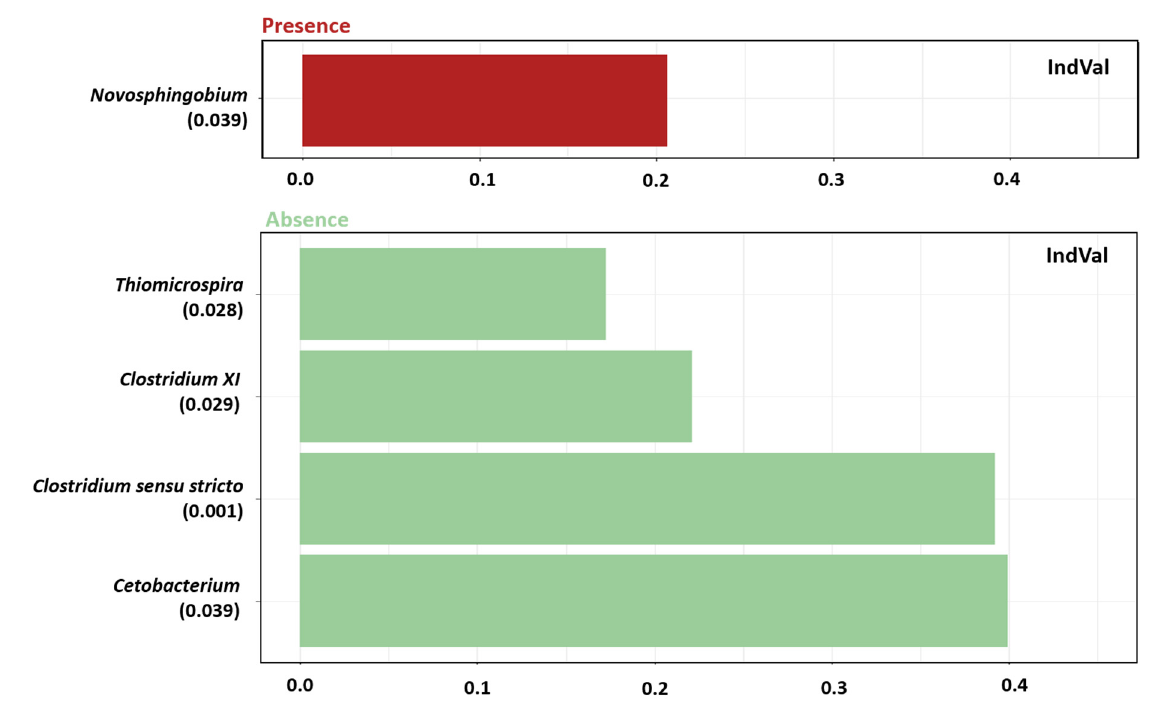
Figure 5. Indicator values of specific bacterial genera of provisioned and non-provisioned sharks; p -values in brackets.